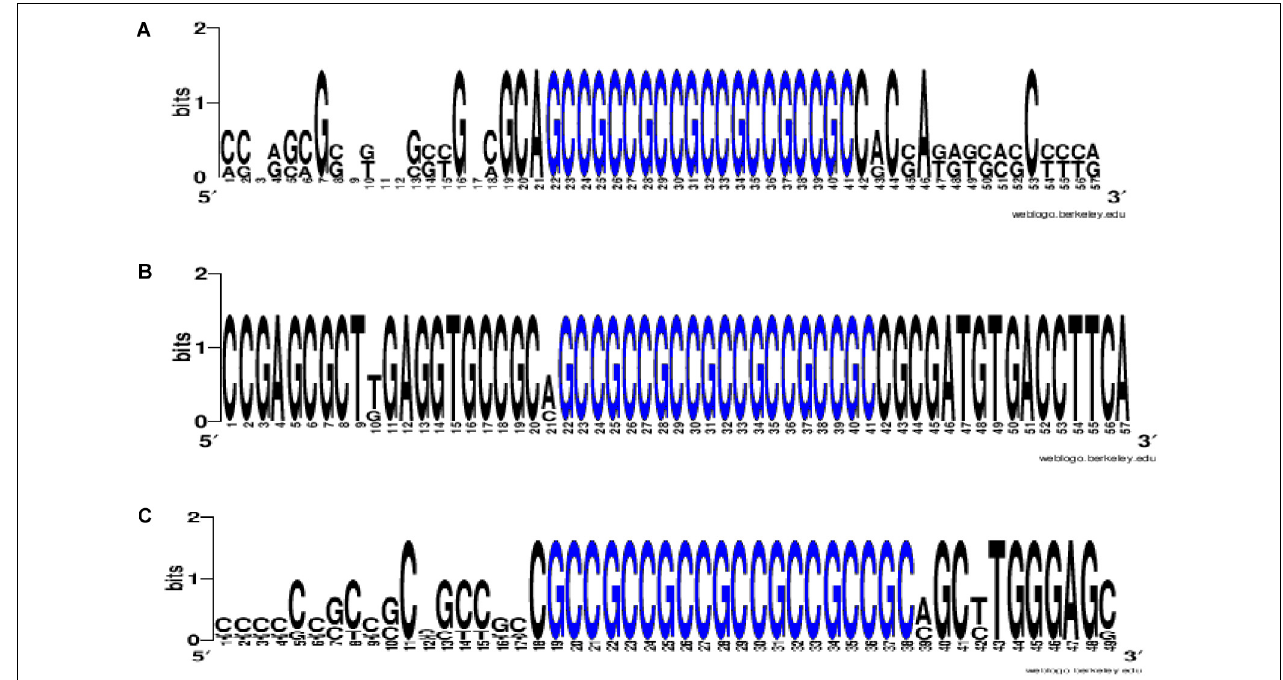
FIGURE 1 | The WebLogo schemes (https://weblogo.berkeley.edu/logo.cgi) of nucleotide sequences for BS clusters in mRNA of GAS6 (A) , NFE2L2 (B) , SCAP (C) orthological genes. Nucleotides of BS clusters are highlighted in blue. Nucleotides of BS clusters mRNA of GAS6 Ggo ( Gîrillà gîrillà ), Hsa ( Homo sapiens ), Mmu ( Macaca mulatta) , Pab (Pongo abelii), Pan ( papio anubis ), Ptr ( pan troglodytes ); nucleotides of BS clusters mRNA of NFE2L2 Ggo , Hsa , Pab , Pan , Ptr ; nucleotides of BS clusters mRNA of SCAP Ggo , Hsa , Mmu , Pab , Pan , Ptr